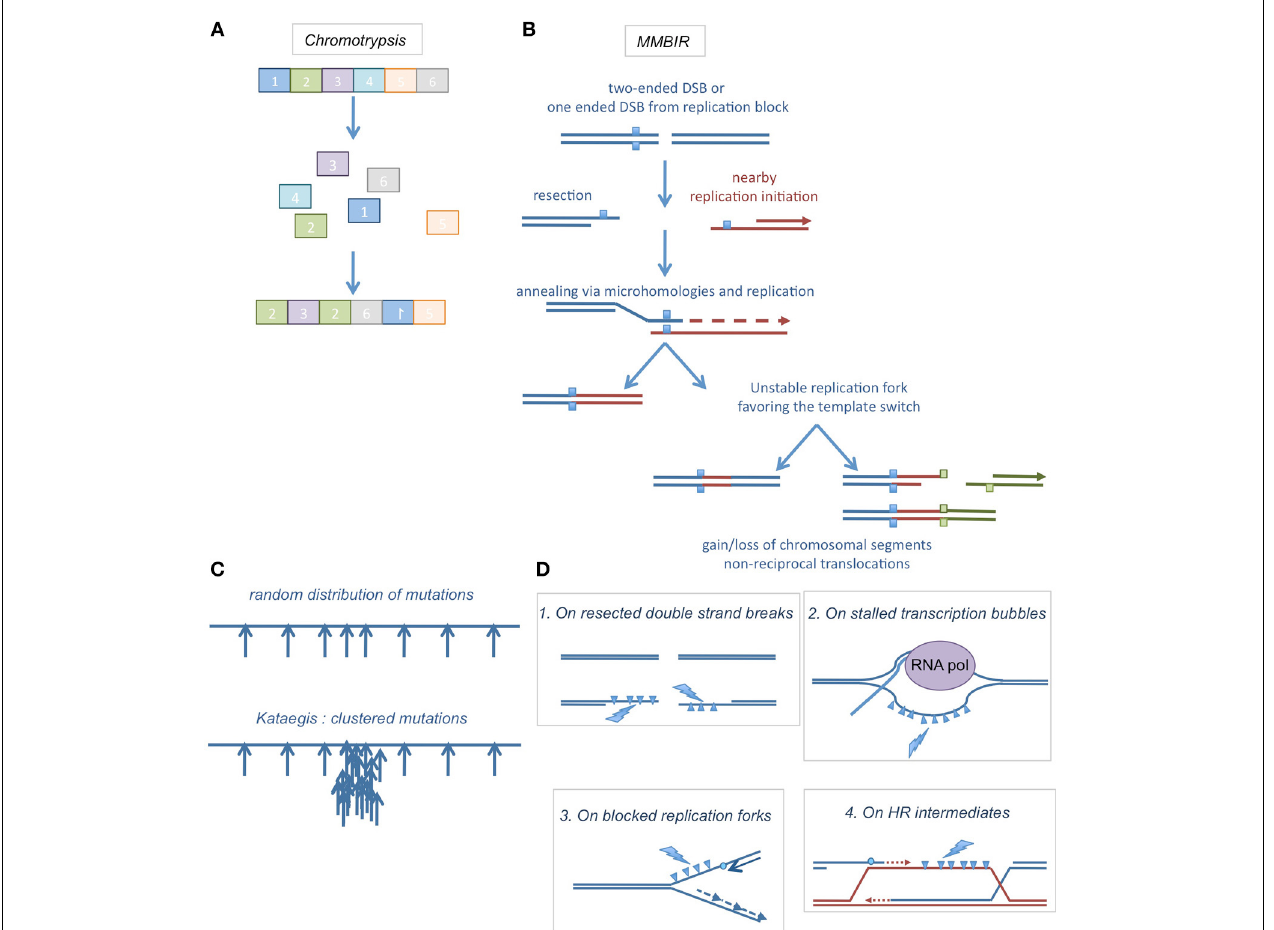
FIGURE 4 | (A) Chromothripsis. Chromosomal shattering into pieces and abnormal re-ligation events, resulting in intra- or inter-chromosomal rearrangements. (B) A suggested model for chromothripsis occurrence, the MMBIR (microhomology mediated break induced replication). A DNA double strand end is resected to generate a 3 (cid:4) overhang that will anneal with microhomologies elsewhere in the genome to initiate replication. This mechanism can lead to more complex rearrangements if it is coupled to